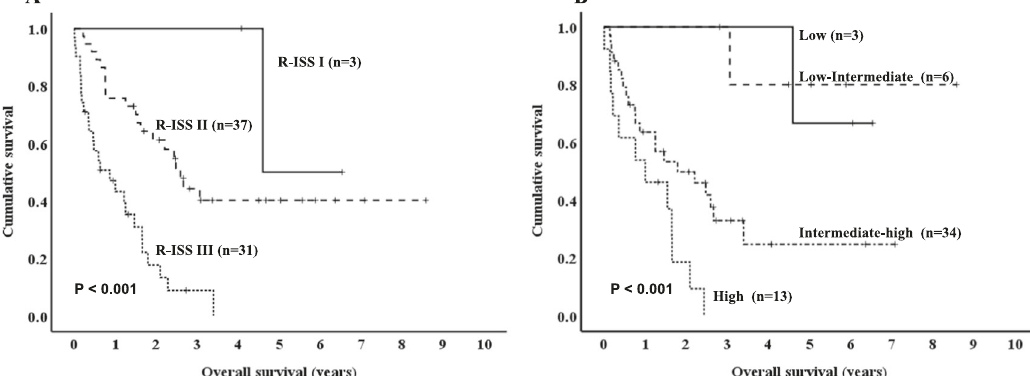
Fig. 3 Prognostic impact of the Revised International Staging System (R-ISS) and Second Revision of the International Staging System (R2-ISS) in primary plasma cell leukemia. Kaplan-Meier survival curves for overall survival based on the Revised International Staging System (R-ISS) ( A ) and Second Revision of the International Staging System (R2-ISS) ( B ) in patients with circulating plasma cells ≥